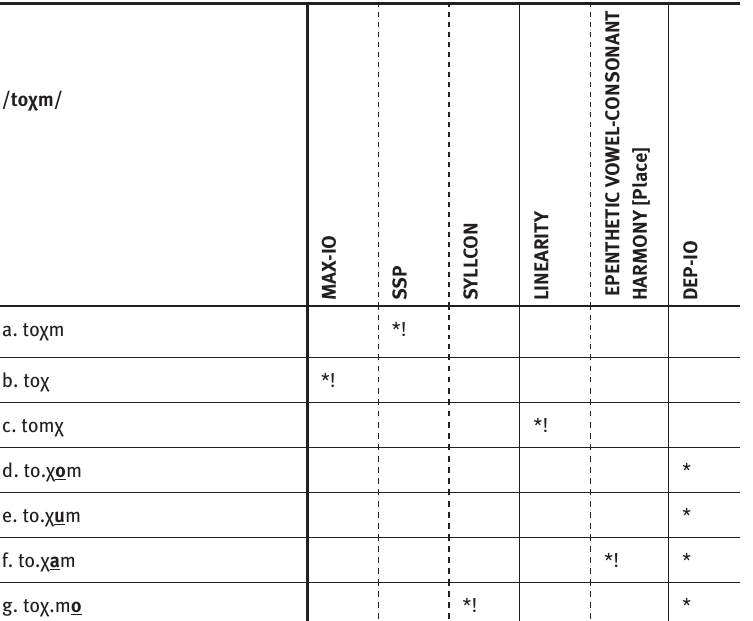
Table 8: MAX-IO, SSP, SYLLCON>>LINEARITY, EPENTHETIC VOWEL-CONSONANT HARMONY [Place]>>